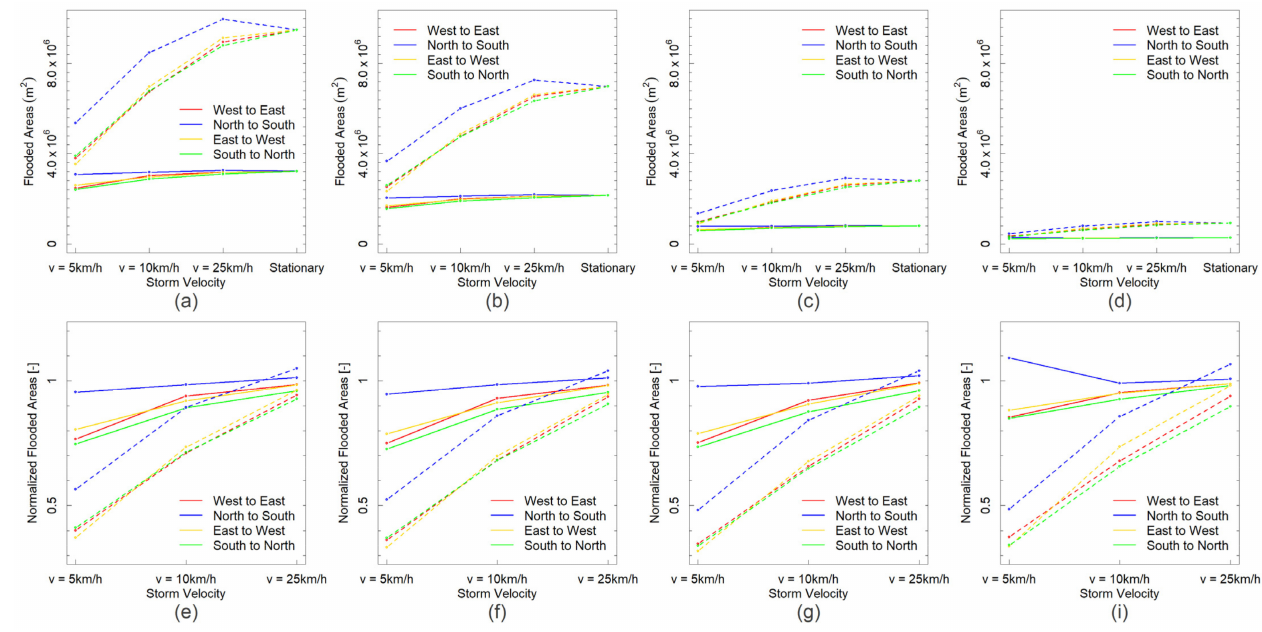
Figure 13. Flooded areas ( a – d ) and normalized flooded areas by the stationary setup ( e – i ) in the two lower floodplains for rain variabilities σ 2 = 0 (solid line) and σ 2 = 100 (dashed line) under the stationary and moving setups with velocities v = 5 km/h, v = 10 km/h, v = 25 km/h with four movement directions. Figure from left to right present water levels above 10 cm, 20 cm, 50 cm and 100 cm